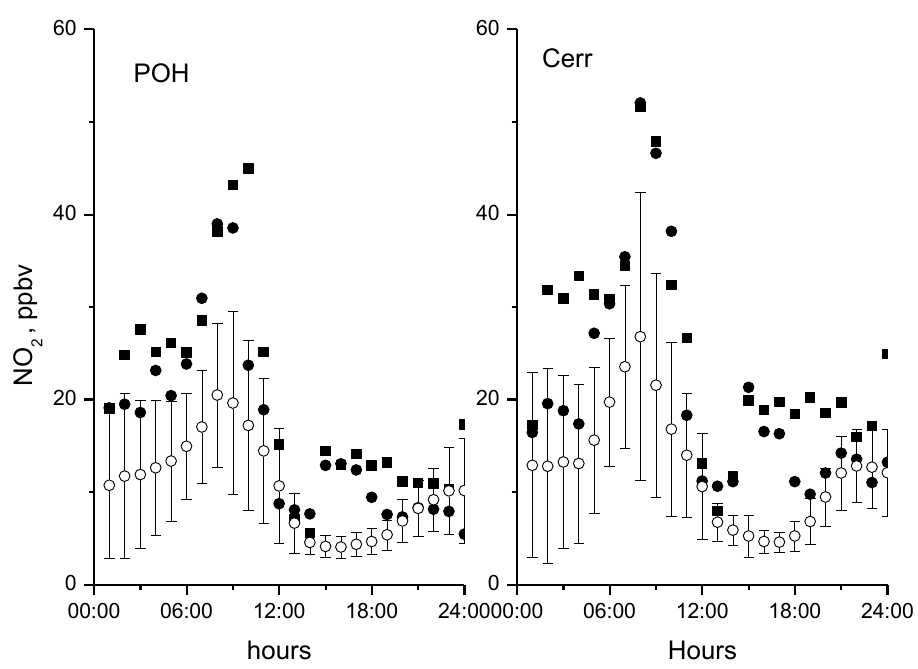
Figure 9. NO 2 daily profile, reference background days (□) and days with active wildfires in Melipilla region. (▪), (•).